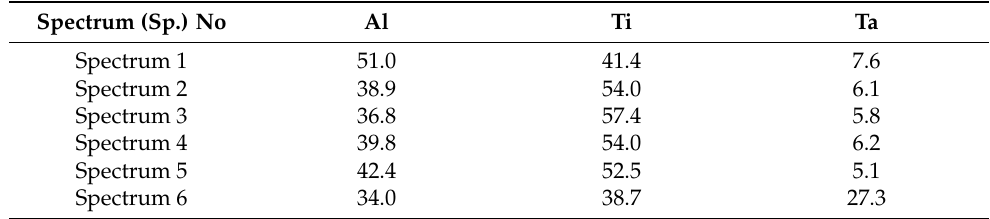
Table 4. Results of EDX analysis of different zones of the Ti-41Al-7Ta cladding layer labeled in Figure 4,